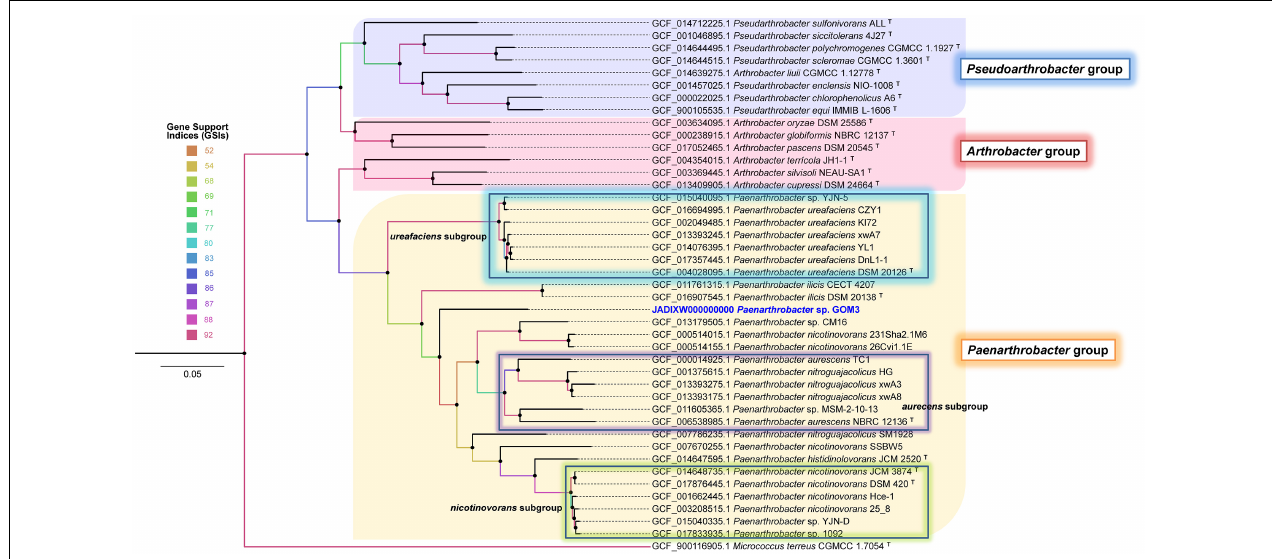
FIGURE 1 | Phylogenomic unrooted tree inferred with 92 housekeeping bacterial core genes in the UBCG pipeline. Gene support indices (GSIs) are represented in color scale per node. Bar 0.05 substitution per site. The Micrococcus terreus CGMCC 1.7054 T genome was used as an outgroup.